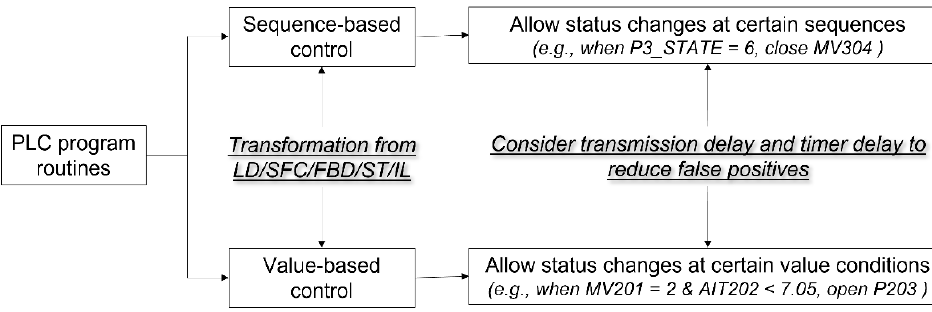
Figure 2. The two kinds of logic expressions from PLC.